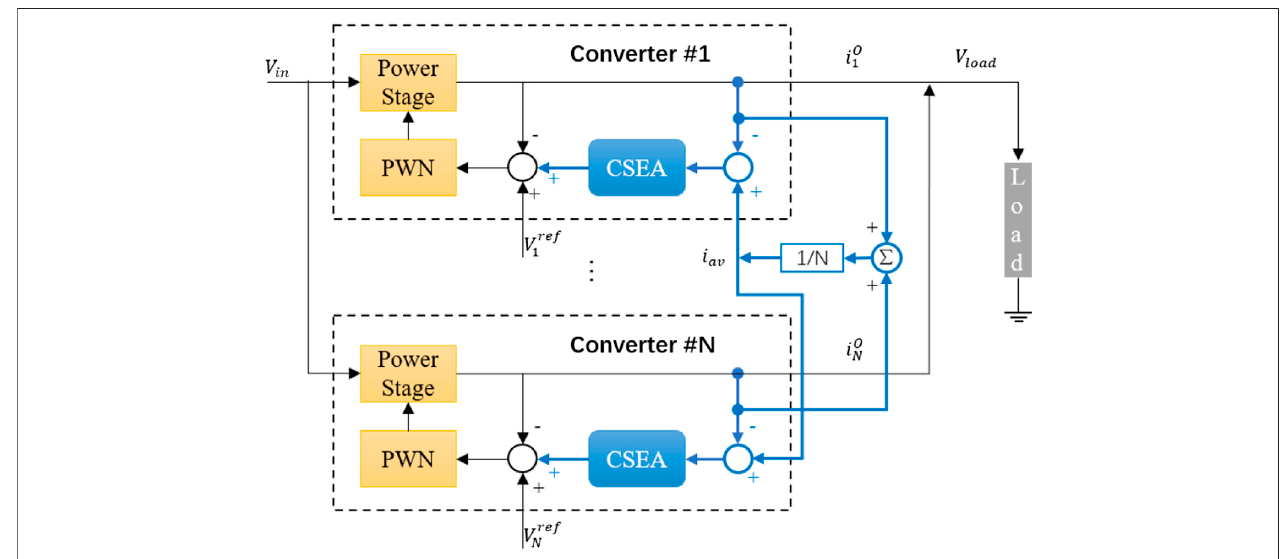
FIGURE 5 | The control technology diagram of average load